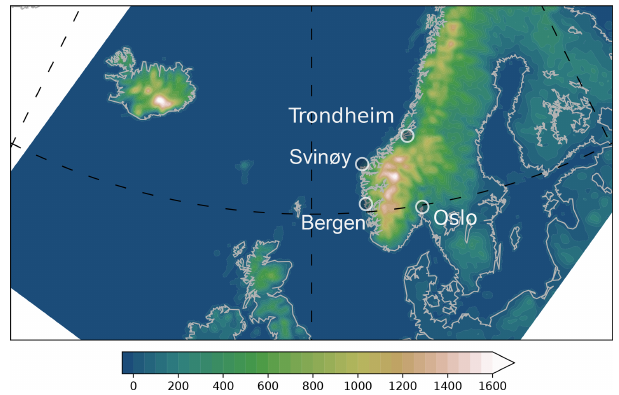
Figure 1. Orographic height map (m) from the NORA10 data set. The white circles show the location of some major cities and the Svinøy lighthouse mentioned in the